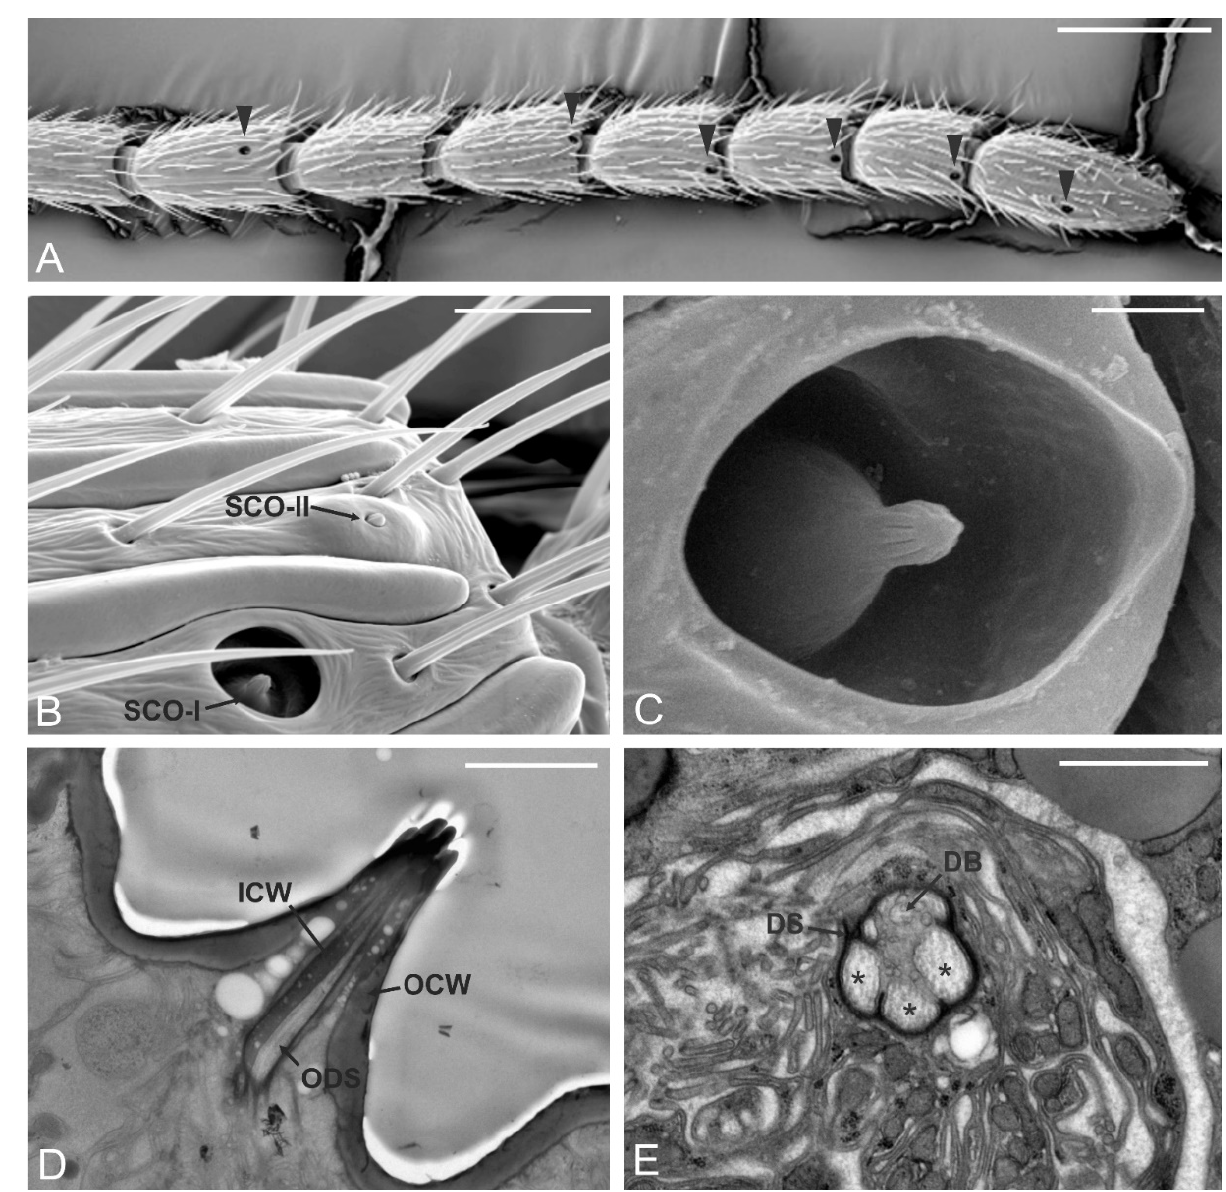
dendrite sheet. A fourth sensory neuron, for which some dendritic branches were found, was also enclosed in the same dendrite sheath (Figure 5E).